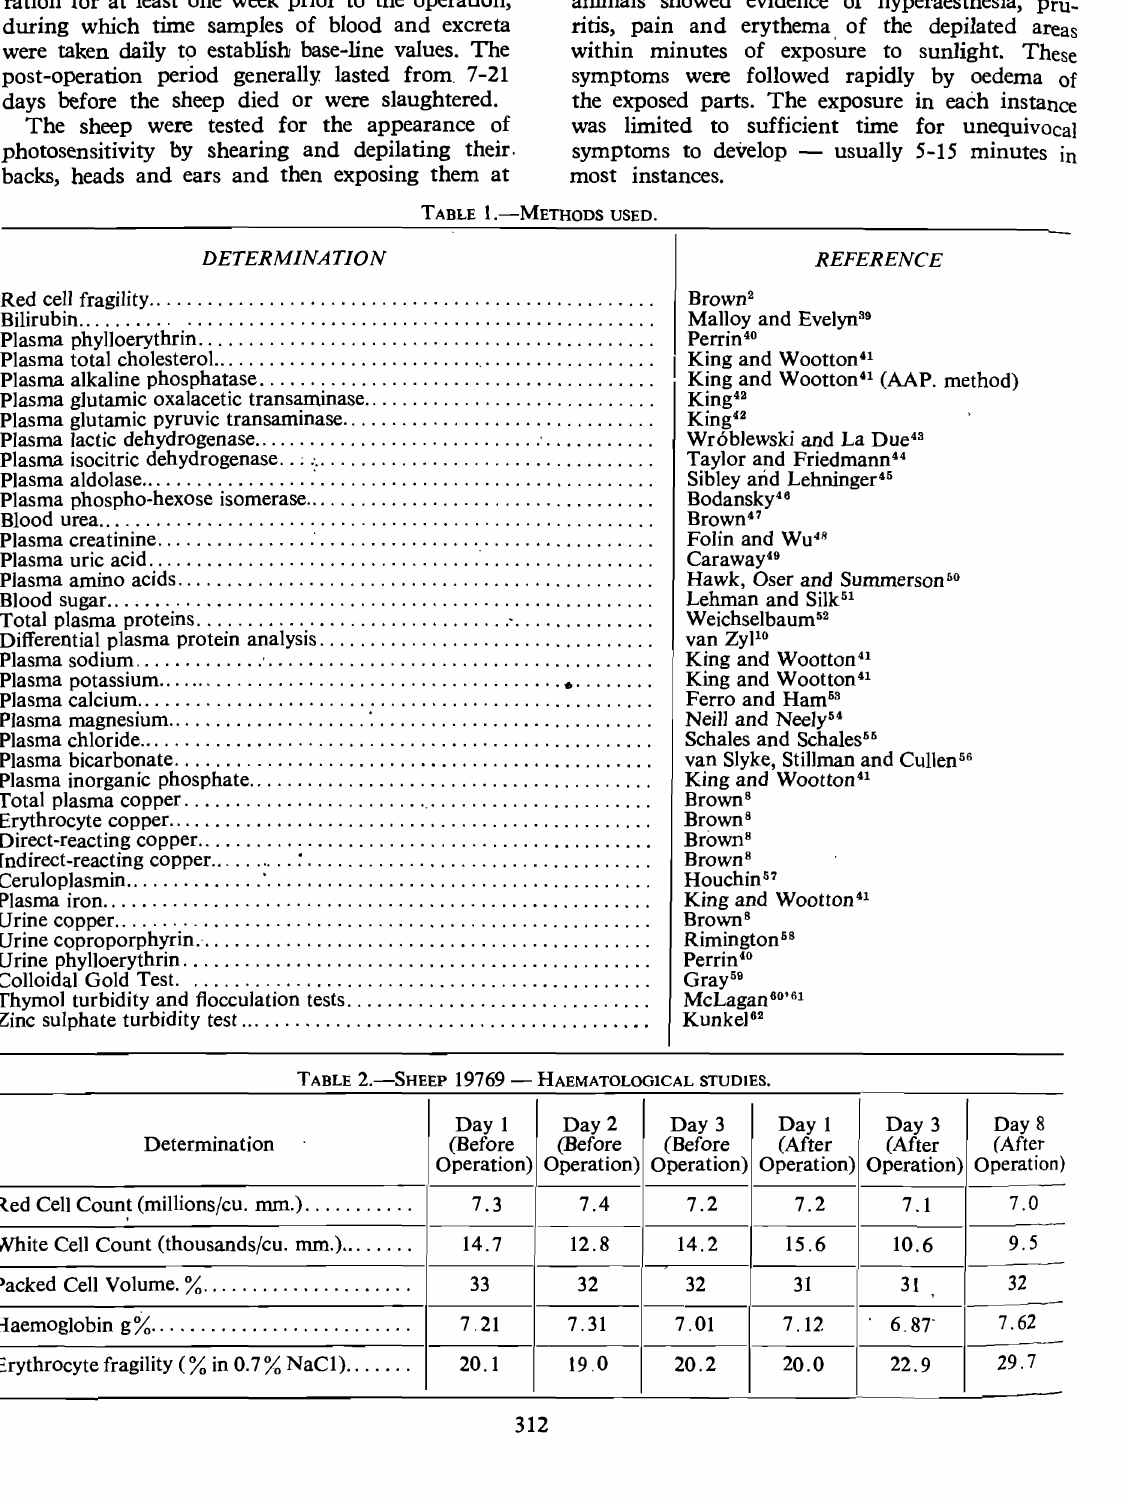
TABLE 2.-SHEEP 19769 - HAEMATOLOGlCAL